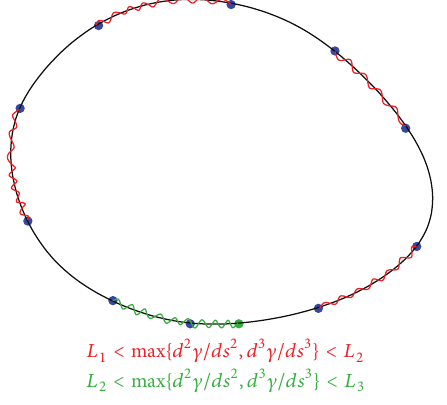
Figure 12: In this schematic figure, we illustrate the alternating perturbation around the curve, keeping the curve 𝐶 1 close to and messing with the second and third derivatives to eliminate any critical points other than isolated maxima and minima. Here, the perturbation is of course greatly exaggerated.